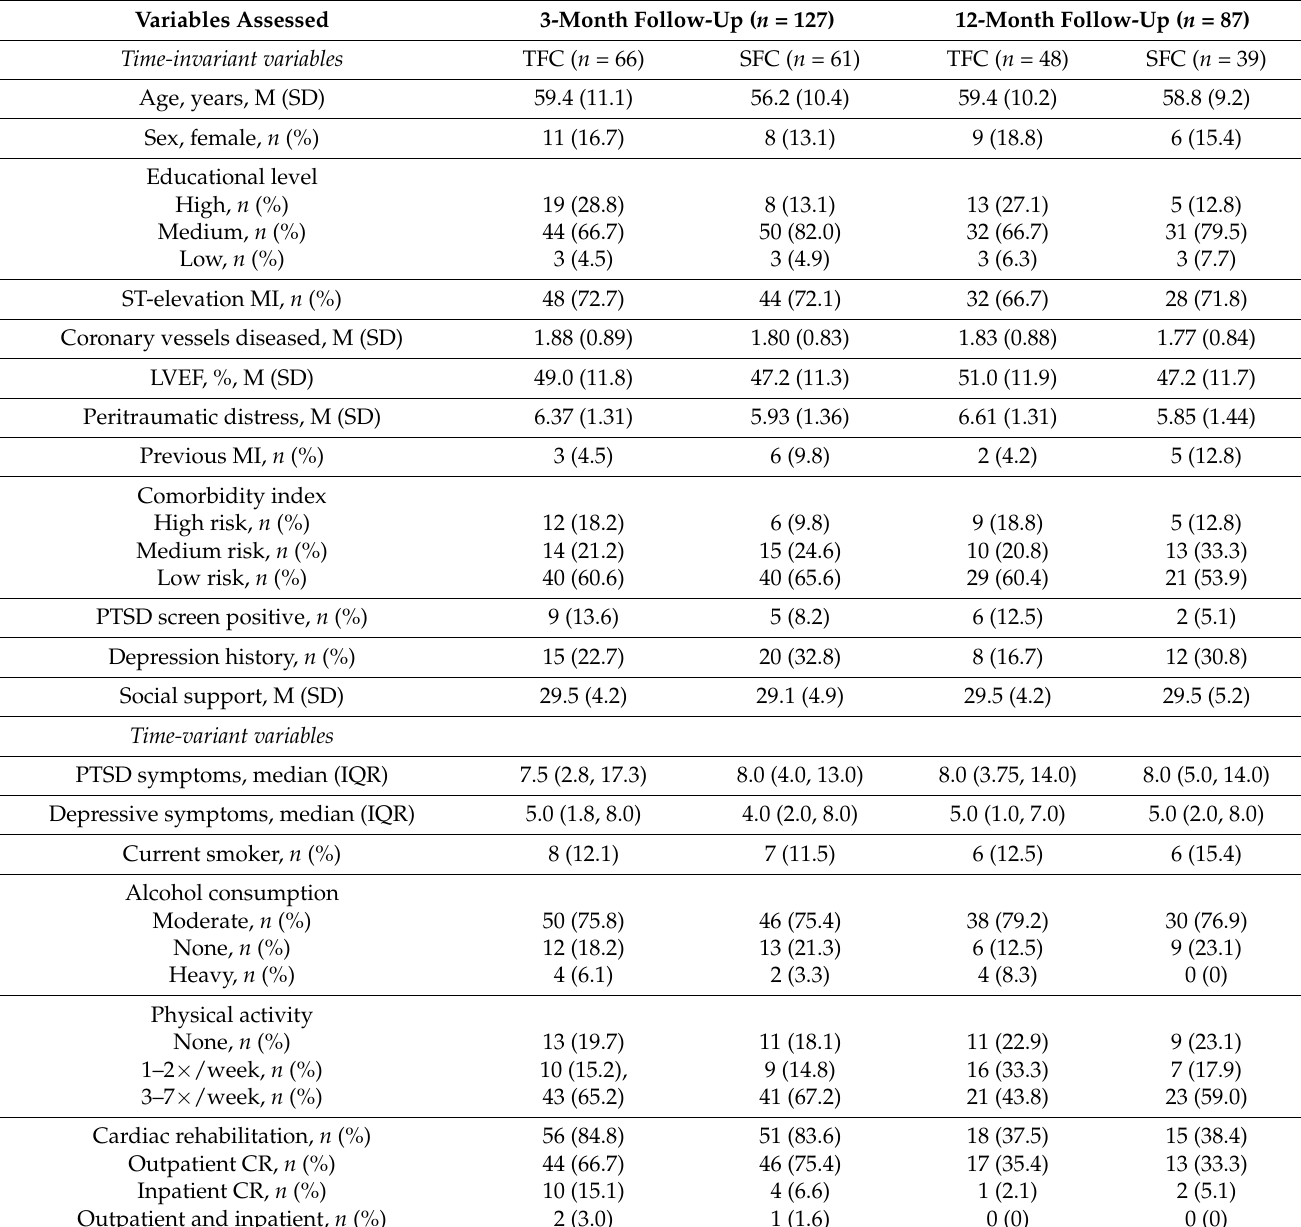
Table 1. Characteristics of study participants in each intervention group at the two